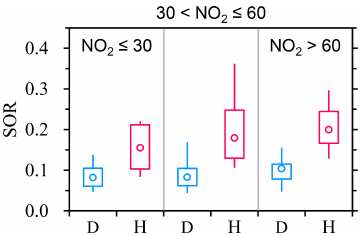
Figure 5. Dependences of (a) sulfate and (b) SOR on RH. Results atively high sulfate values are typically observed for the conditions with RH above 80%, which is also the case for SOR. There appear to be several outliers showing considerably higher sulfate or SOR than other samples at similar RH. All the outliers occurred during the 2018–2019 measurement period, and most of them were ac- companied with extremely high levoglucosan concentrations (above 5µg/m 3 ) , as highlighted by the red arrows. The outlier highlighted by the blue arrow was observed at an ambient temperature of above 10 ◦ C, which was uncommon for the heating season. The outliers indicate that factors other than RH were also at play in sulfate for- mation, but the influences were evident for only several samples.